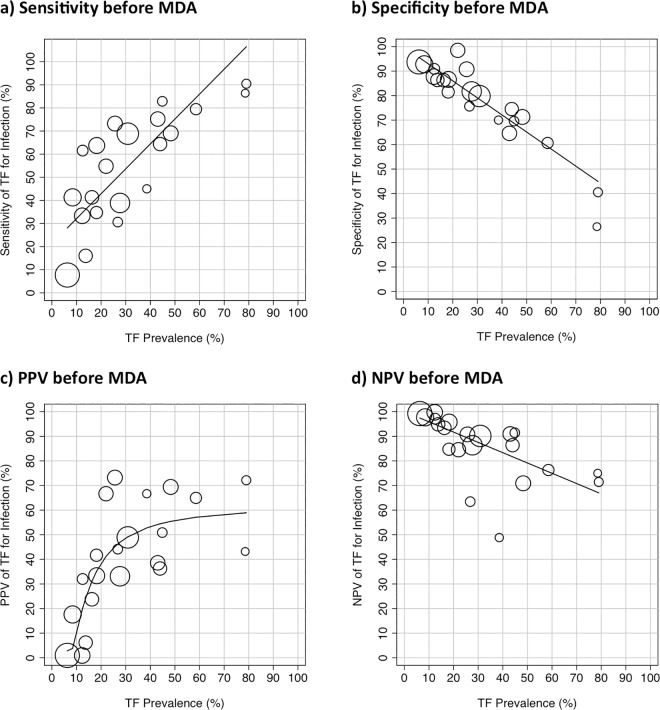
The relationship between the individual level presence of Active Trachoma (TF or TF/TI) and the detection of C. trachomatis infection by community TF prevalence before the introduction of MDA.(a) Sensitivity of TF for infection. (b) Specificity of TF for infection. (c) Positive Predictive Value (PPV) of TF for C. trachomatis infection. (d) Negative Predictive Value (NPV) of TF for C. trachomatis infection. Data from population-based studies, summarised in Table 1. The size of the circles reflects the sample size. Line fitted by linear regression, weighted by the size of the studies, except for the PPV which was fitted by polynomial.